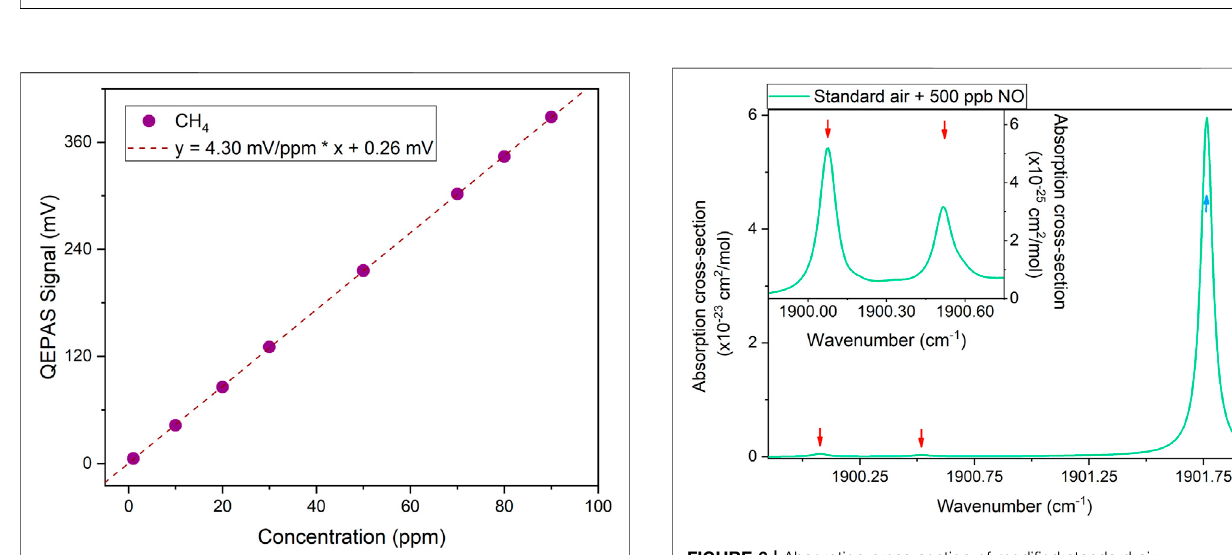
FIGURE 4 | 2f-QEPAS spectra collected for (A) H 2 O at a concentration of 1.8% and (B) CH 4 at a concentration of 30 ppm, both in N 2 .